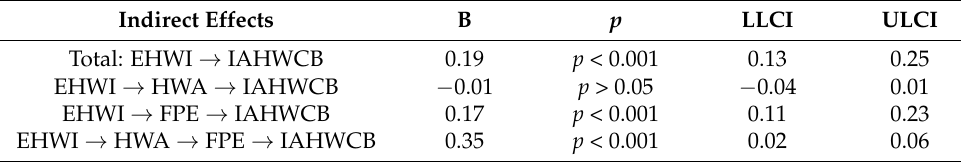
Table 3. Summary of mediating effect